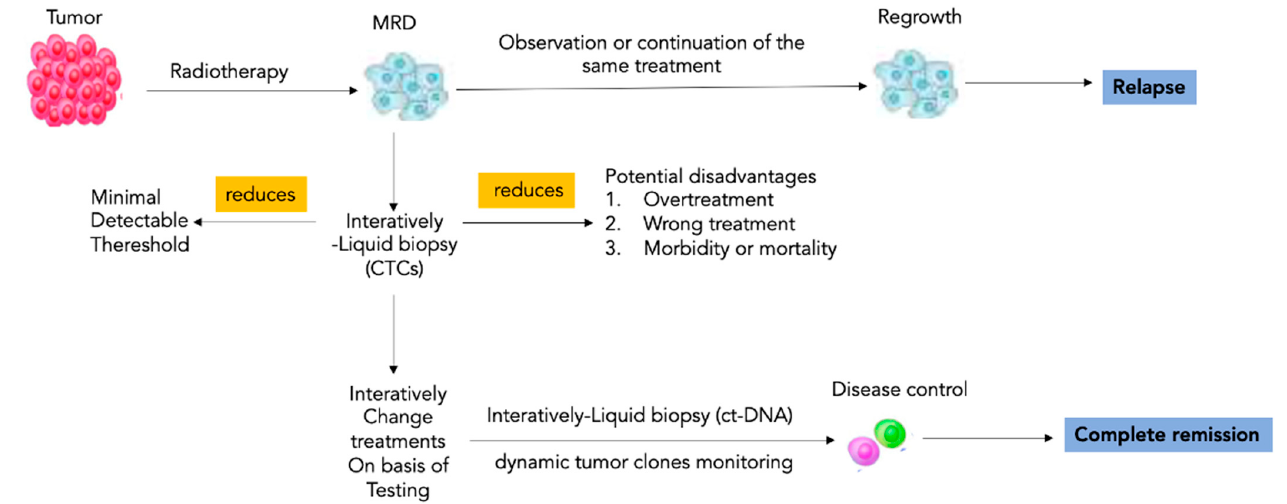
Figure 2. Impact of liquid biopsy in radiotherapy. Risk stratification through liquid biopsy allows care models to be personalized to the needs of patients within each cohort. LB-based longitudinal scans allow directing the radiotherapy toward a more or less aggressive treatment to modulate the radiotherapy dosage or to induce the choice of more aggressive therapeutic regimens. Interactive liquid biopsy has a key role to individuate and maintain the right tailored balance between the minimal detectable threshold of cancer cells and the emergent signs of overtreatment. Note: MRD, minimal residual disease; CTCs circulating tumor cells; ct-DNA, circulating tumor DNA.